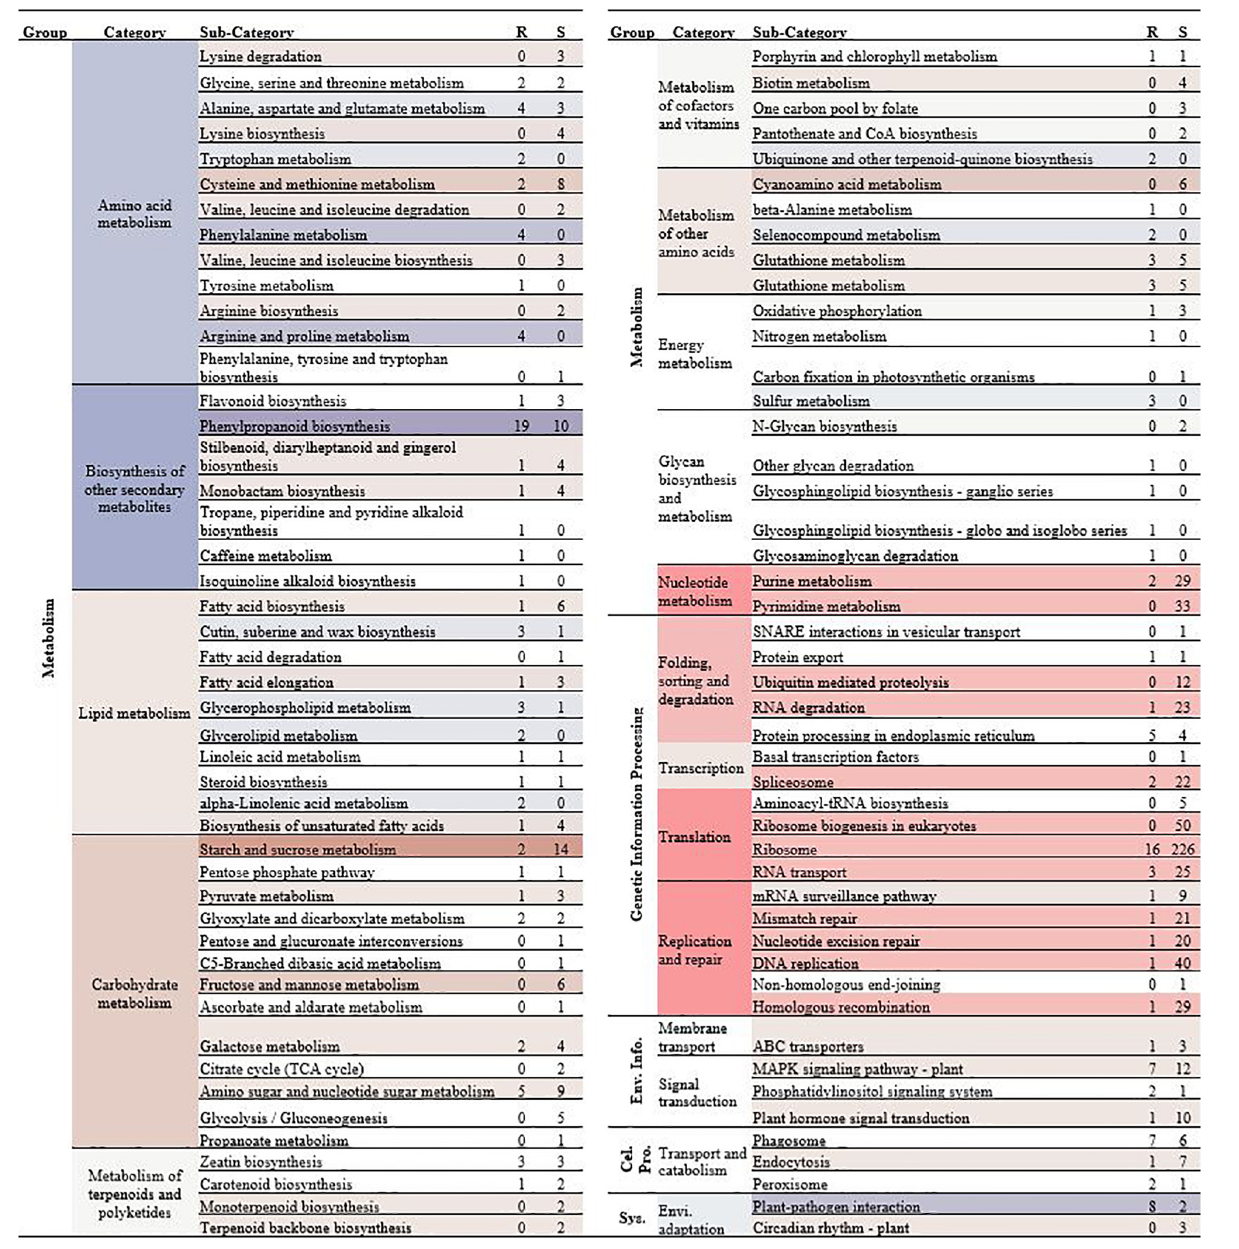
involved in cell wall biosynthesis were highly upregulated,